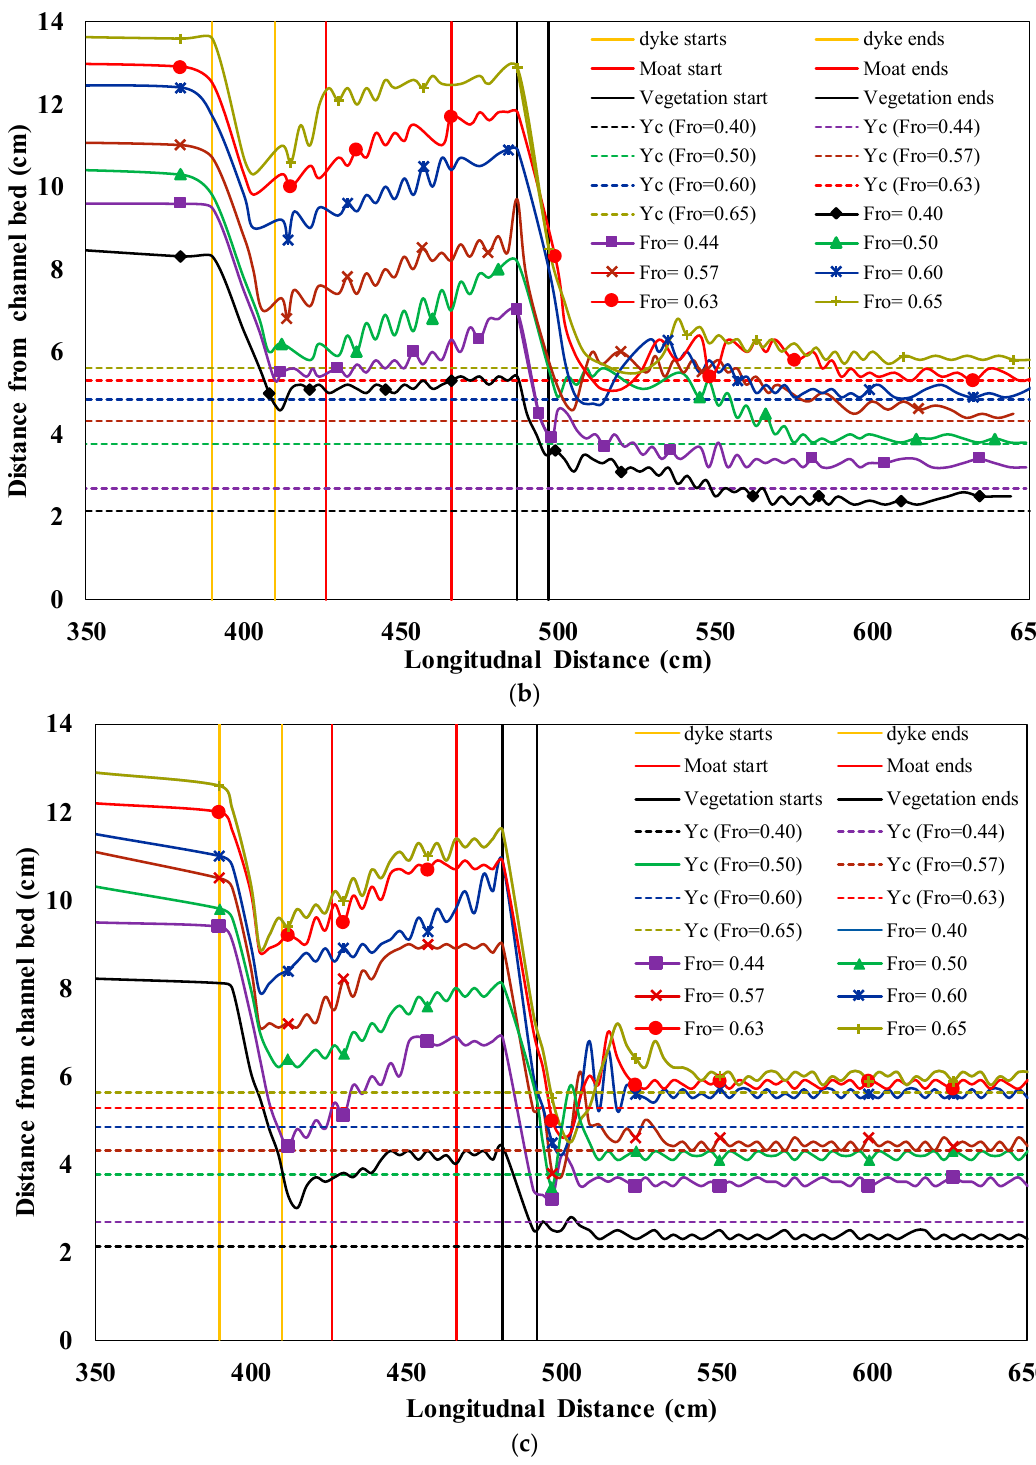
Figure 8. Experimental observations of water surface profiles ( a ) dike, trapezoidal moat and sparse vegetation (DTMVS), ( b ) dike, trapezoidal moat, and intermediate vegetation (DTMVI) and ( c ) dike, rectangular moat and intermediate vegetation (DRMVI).